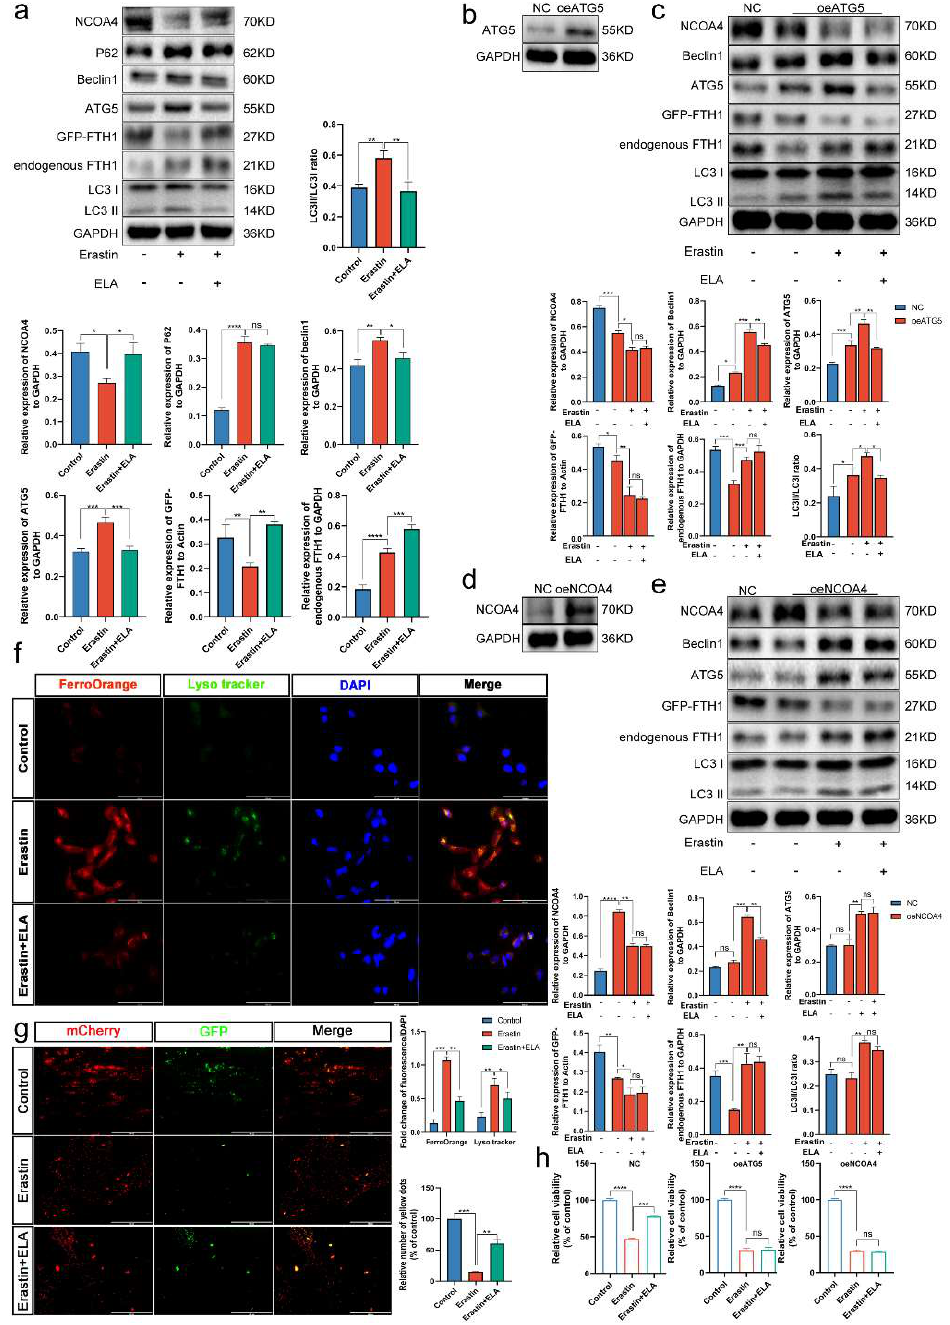
Figure 7. The ferritinophagy pathway plays a role in the regulation of ferroptosis by Elabela. ( a ) HTR-8/Svneo cells treatment with Erastin (5 μm) and Elabela (0.01 μm) for 12 h. WB detection the protein levels of NCOA4, Beclin1, ATG5, LC3B, P62, endogenous FTH1 and exogenous FTH1; n = 3. ( b ) WB validates OE-ATG5 plasmid interference efficiency. ( c ) HTR-8/Svneo cells were interfered with by OE-ATG5 plasmid and then treated as indicated, wb detection of the protein levels of NCOA4, Beclin1, ATG5, LC3B, endogenous FTH1, and exogenous FTH1; n = 3. ( d ) WB validates OE-NCOA4 plasmid interference efficiency. ( e ) HTR-8/Svneo cells were interfered with by OE- NC0A4 plasmid and then treated as indicated, wb detection of the protein levels of NCOA4, Beclin1, ATG5, LC3B, endogenous FTH1, and exogenous FTH1; n = 3. ( f ) After treatment, fluorescence images of lysosomes(green) and Fe2+(red) co-localization in HTR-8/Svneo cells as indicated; n = 3. Scale bars: 100 μm. ( g ) After treatment, fluorescence images of GFP/mCherry spots as indicated; n =